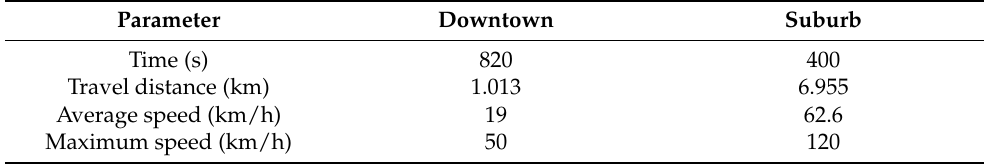
Table 4. Cycle parameters of the ECE +